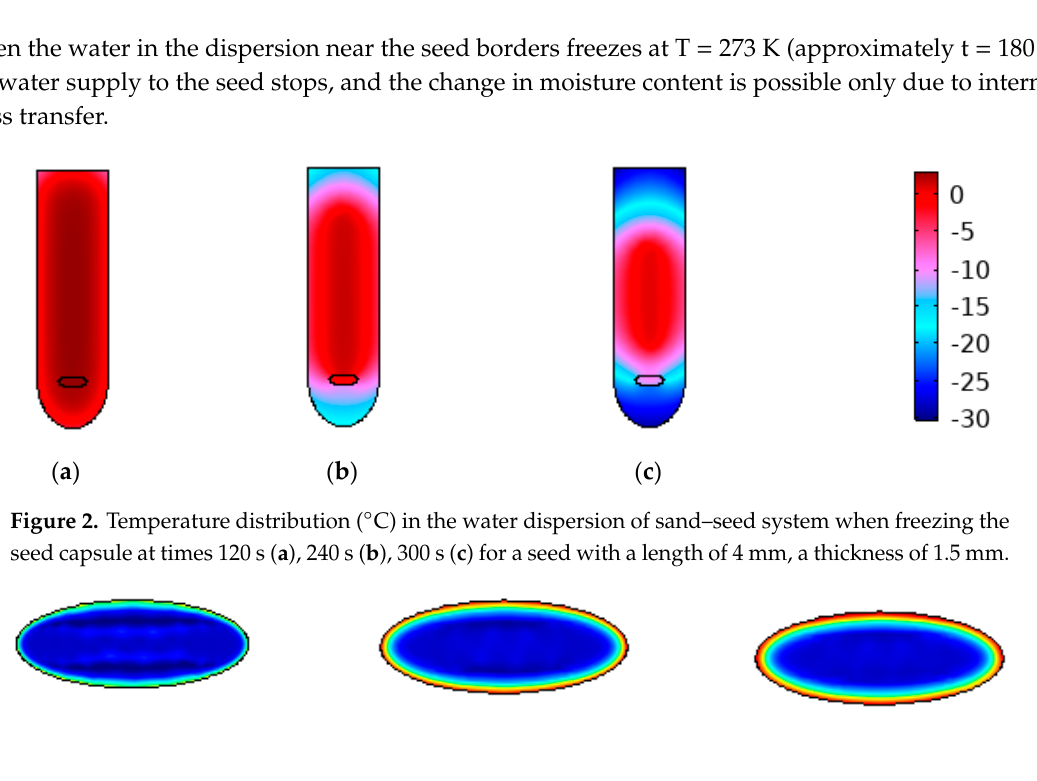
Figure 3. Distribution of moisture content (kg kg − 1 ) in the seed when the seed capsule is frozen at times 30 s ( a ), 120 s ( b ), 240 s, 300 s ( c ) for a seed with length of 4 mm, and thickness of 1.5 mm.